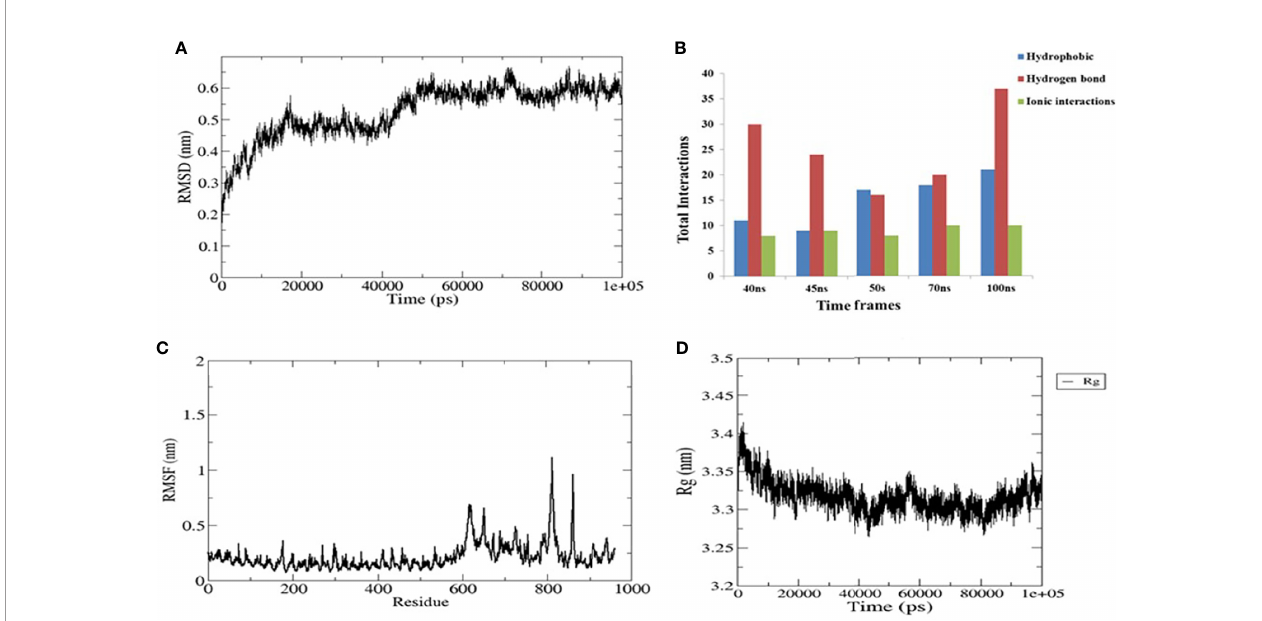
FIGURE 6 | Plots of the molecular dynamics simulation (MDS) of the vaccine construct and the TLR4 complex. (A) Backbone root mean square deviations (RMSD). (B) Interface interaction plot between the construct and TLR4. (C) Residue-wise root mean square fl uctuation (RMSF) plot. (D) Radius of gyration. The start residue 27 in TLR4 PDB is represented as